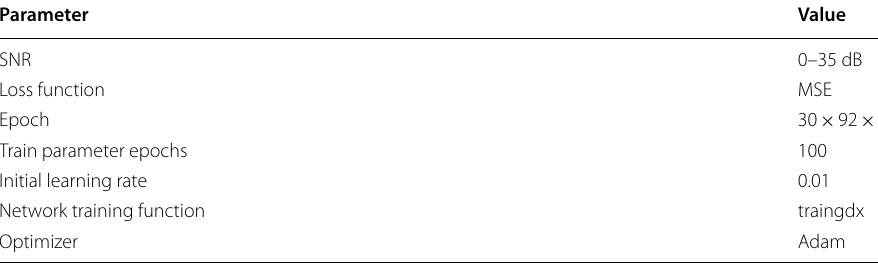
Table 3 S ystem network